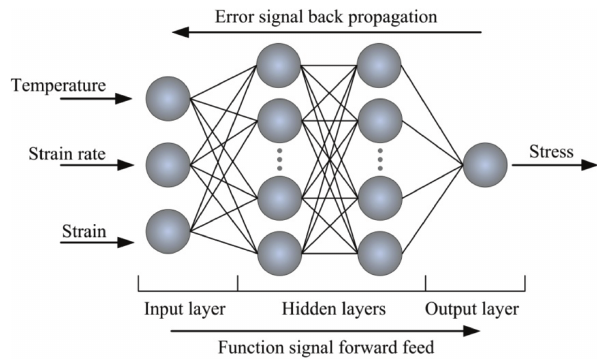
Figure 3: The schematic representation of the BP-ANN architecture.